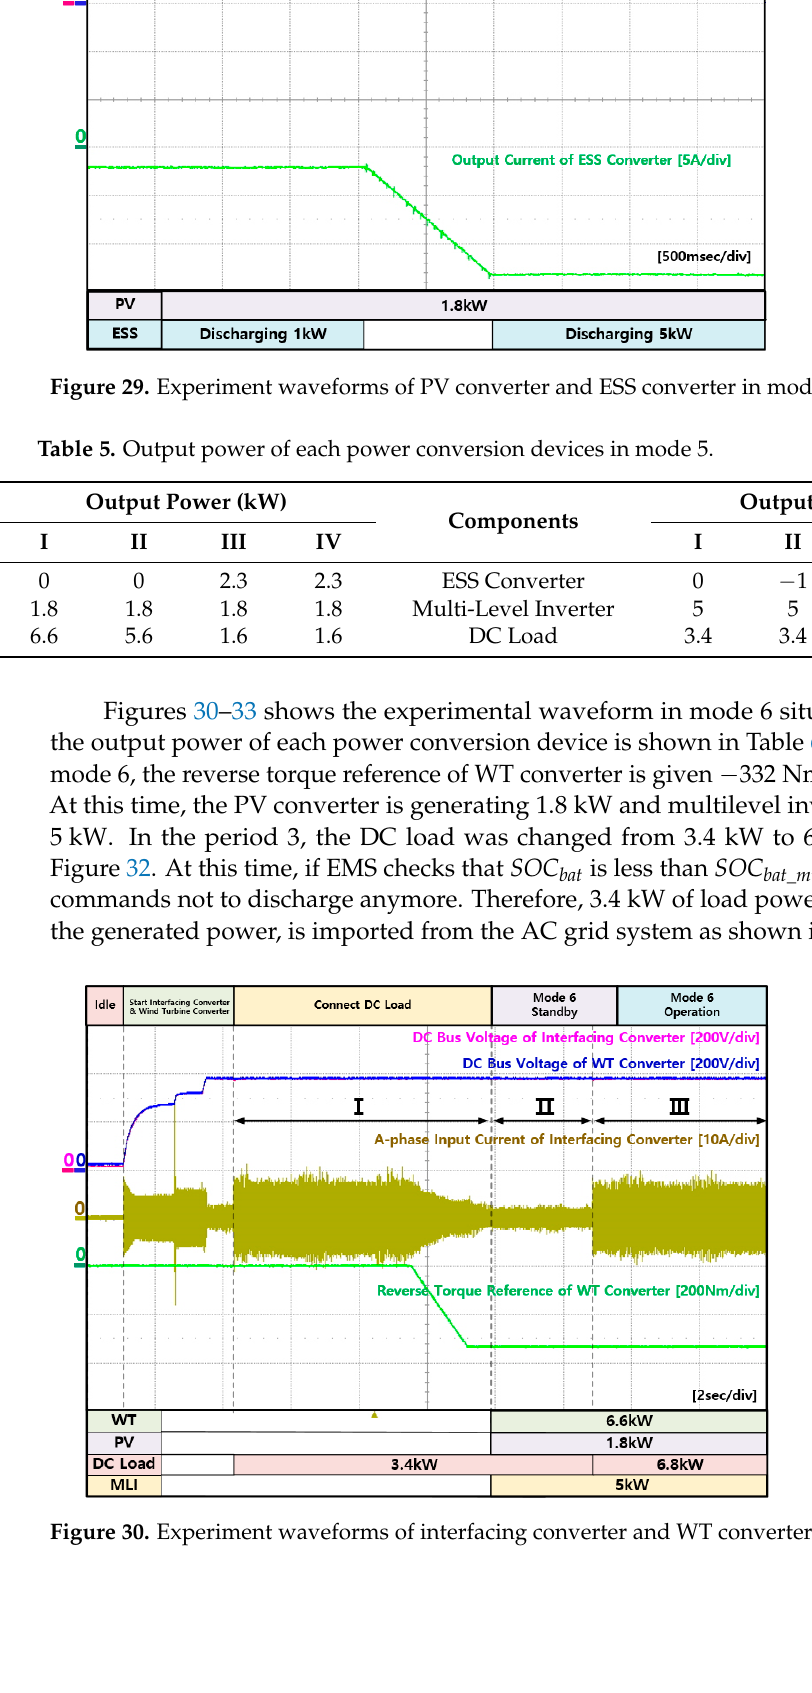
Figure 31. Experiment waveforms of interfacing converter at AC grid in mode 6. Figure 32. Experiment waveforms of DC load and multi-level inverter in mode 6.